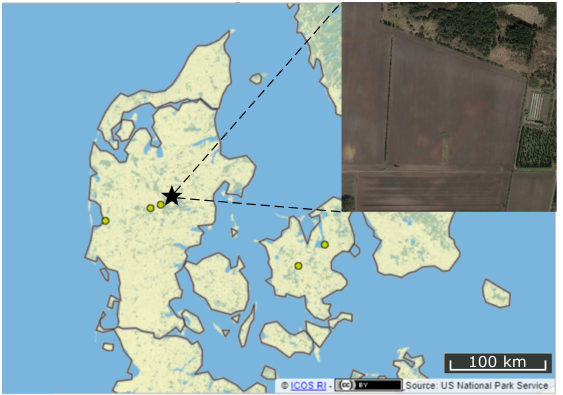
Figure 1. The location of the study site ( (cid:63) ) in Mid-Jutland (DK). The inset shows a top-down view of the field site and the surrounding area. Source: www.icos-cp.eu (accessed on: 8 August 2021) and Google Earth